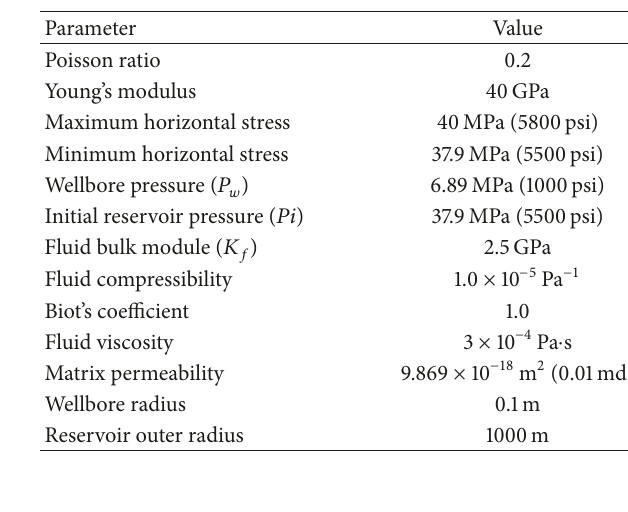
Table 1: Reservoir inputs used for validation of poroelastic numer- ical model using circular homogenous reservoir.